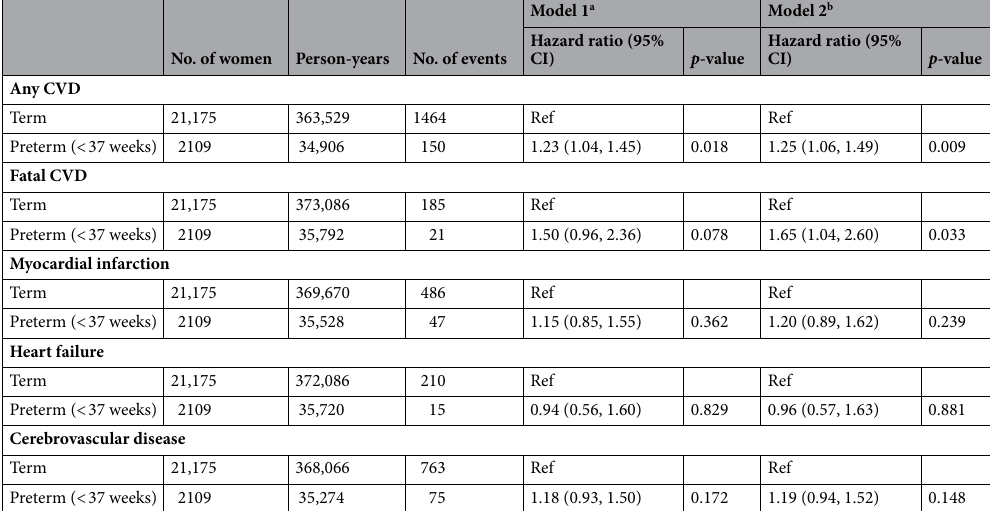
No. of women Person-years No. of